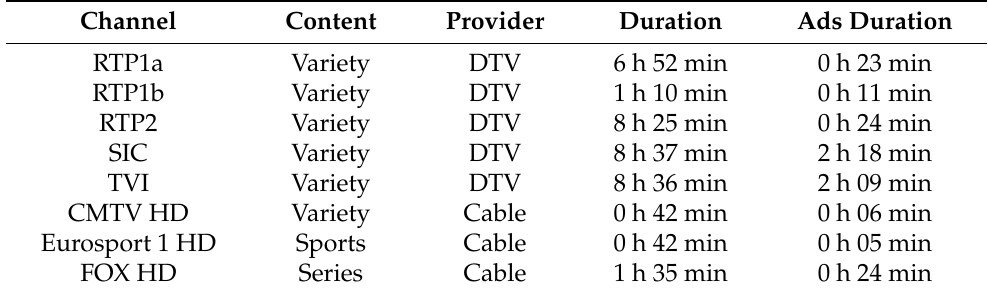
Table 1. General overview of the captured